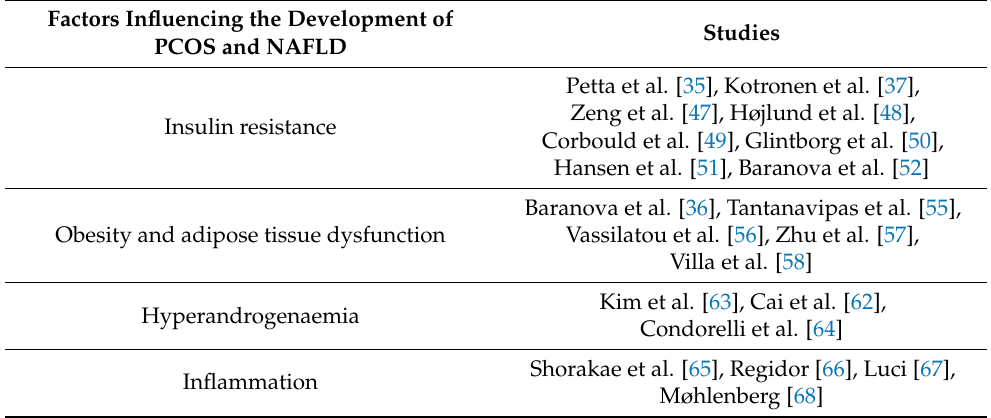
Table 2. Pathophysiological mechanisms involved in the development of NAFLD in PCOS women. Factors Influencing the Development of PCOS and